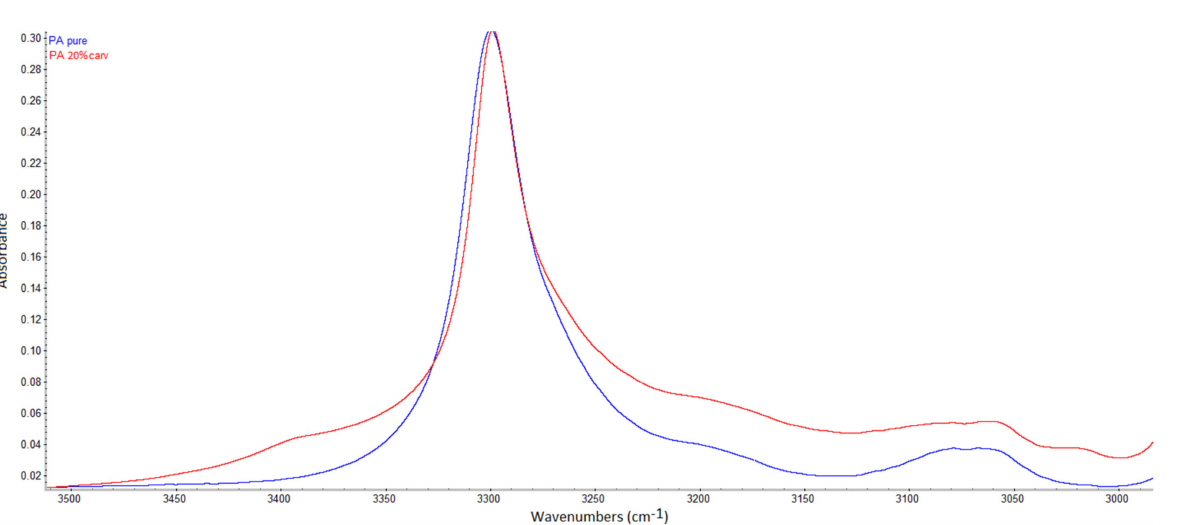
Figure 6. N–H bending vibration band in polyamide (peak at 1536 cm − 1 ) and carvacrol-impregnated polyamide (peak at 1534 cm − 1 ).